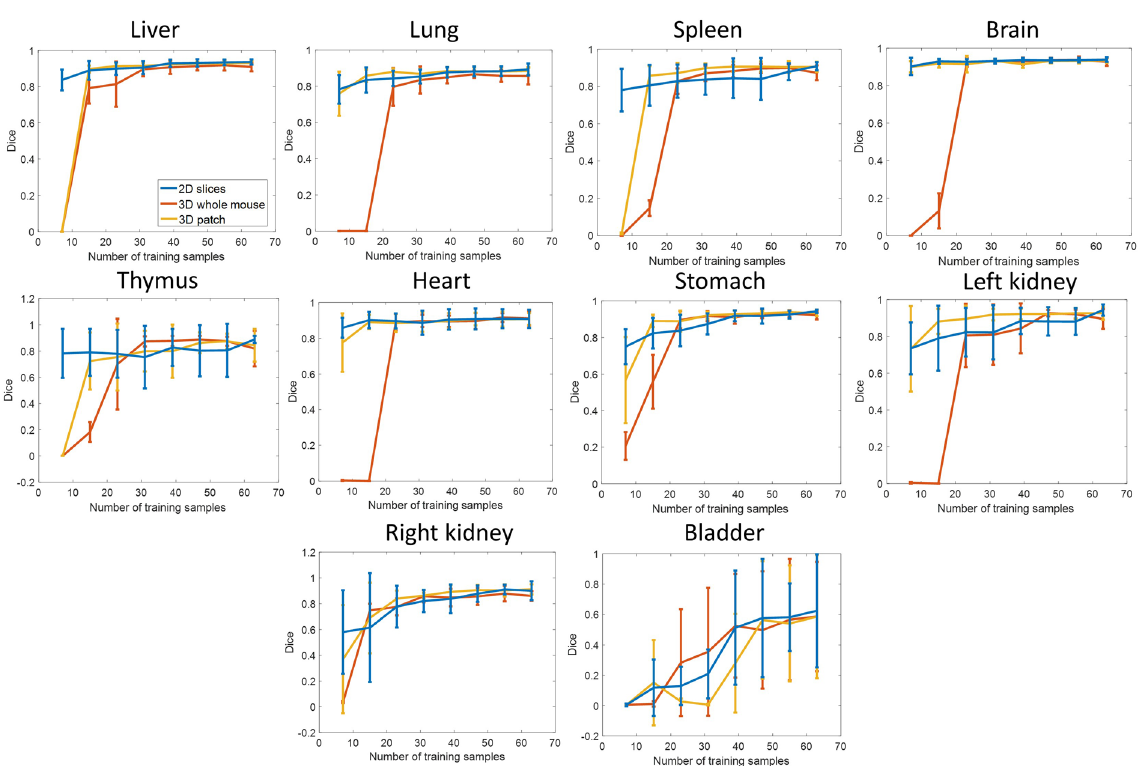
Figure 7. Learning curves showing Dice scores against numbers of training data for the three models, across all organs. 2D-slices had the best performance, given a small training dataset with seven mice. Regression analyses were performed to predict the Dice score given a larger training dataset (see text for